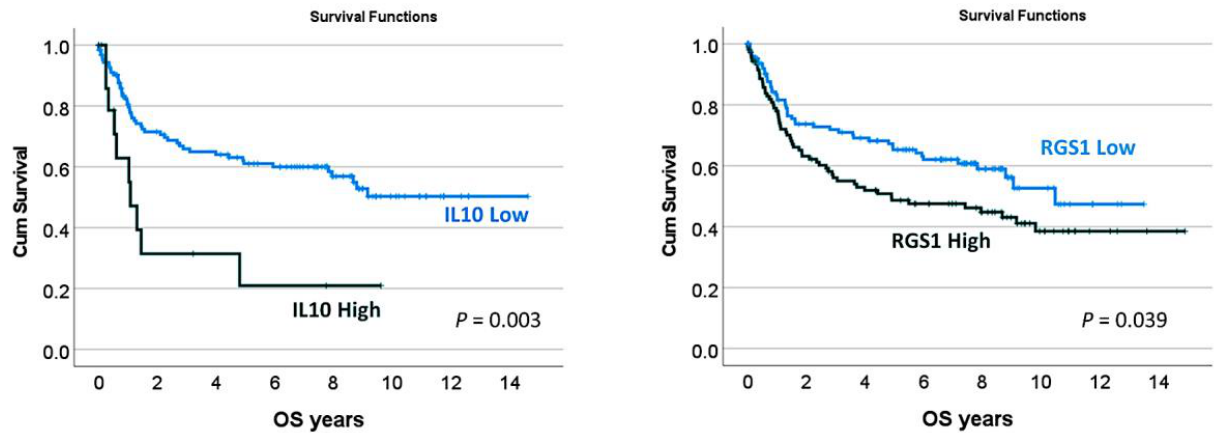
Figure A2. Prognostic values of IL-10 and RGS1 in DLBCL. We recently described the prognostic value of the immunohistochemical expression of IL-10 and RGS1 in diffuse large B-cell lymphoma [18,19,32]. These two markers are associated with high infiltration of immune regulatory tumor-associated macrophages (IL-10-positive TAMs), and to 1q copy-number gain, respectively. This spindle cell variant case was also positive for these two markers. The clinical relevance of this finding should be explored in a larger series of spindle cell cases.